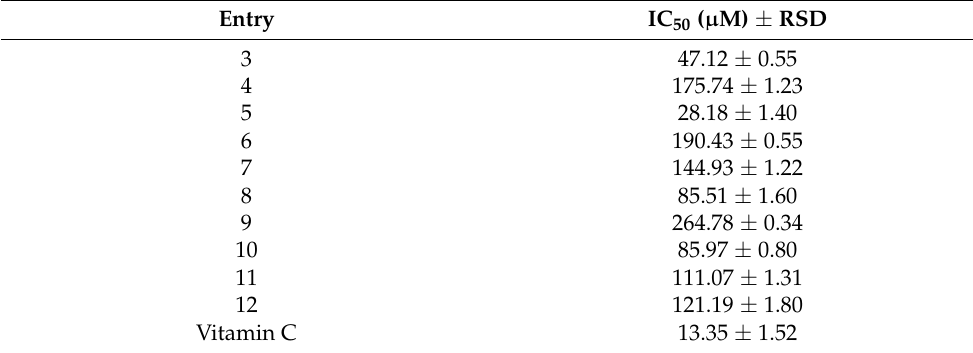
Table 4. Antioxidative activity of synthesized compounds shown as the IC 50